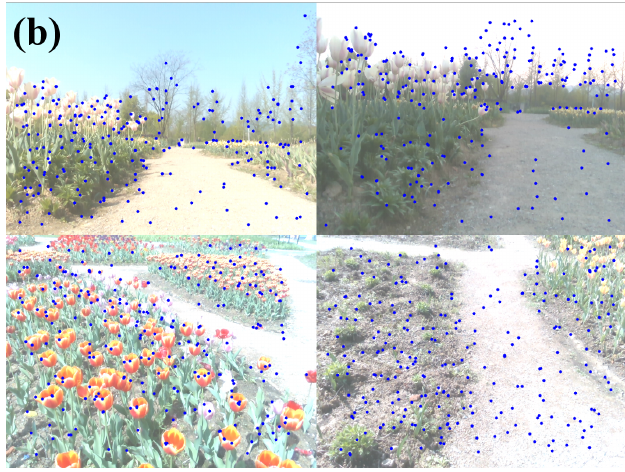
Figure 13. Comparison of feature extraction results of the two algorithms. ( a ) Traditional ORB algorithm; ( b ) proposed algorithm. Table 2. Comparison of algorithm data indicators in different scenes: N f is the number of feature points; t is the time consumption of the algorithm; ρ is the uniformity; and c is the aggregation